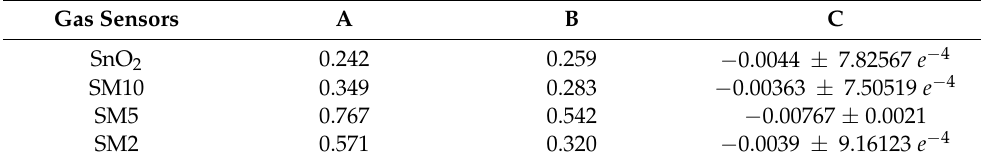
Figure 6. ( a ) Dynamic response recovery curves of four gas sensors to 0.5–50 ppm ethanol. ( b ) Logarithmic fitting curve of response value of four gas sensors to 0.5–30 ppm ethanol. Table 2. The values of A, B, and C in Formula (3) of the fitting curves of different sensors. Gas Sensors A B